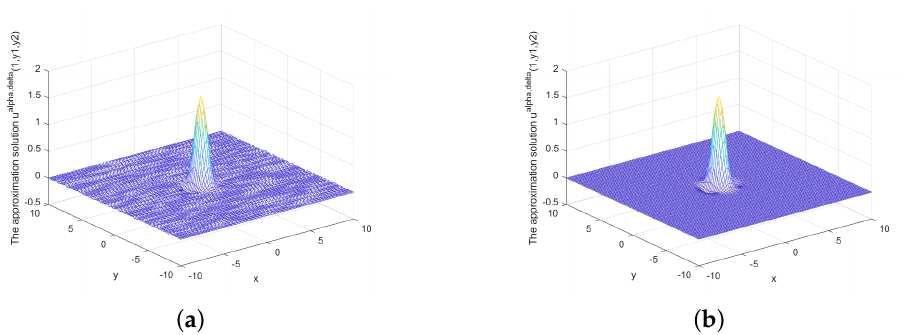
Figure 5. ( a ) The regularized solution when x = 0.5, δ = 1 × 10 − 6 , ( b ) The regularized solution when x = 0.5, δ = 1 × 10 − 7 under prior